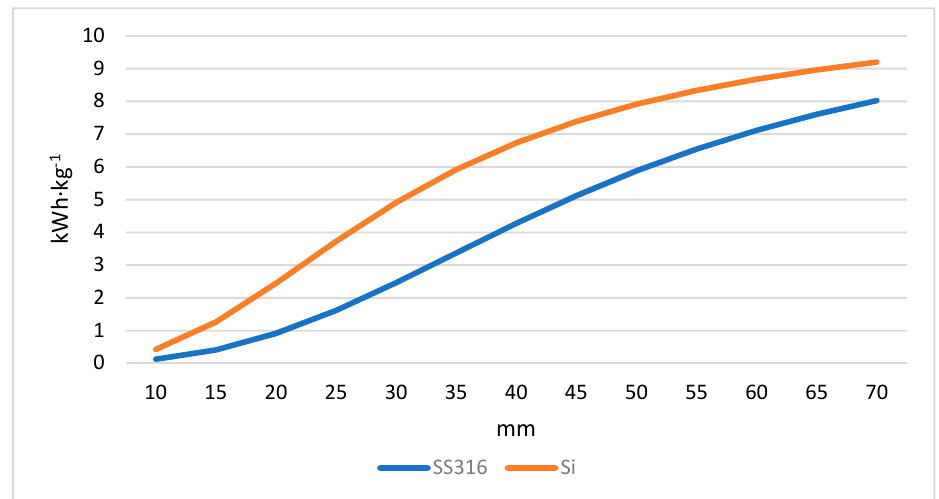
Figure 9. GED for spheres made of CFEP, equipped with a microchip, made of either SS316 or Si, for ID from 10 to 70 mm, at 700 daN cm − 2 of inside pressure.